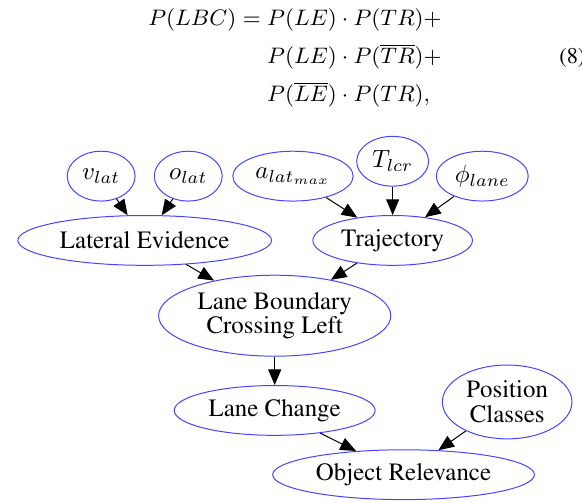
Figure 8: Representation of the reduced BN to determine the rel- evance of an object, located right to the ego